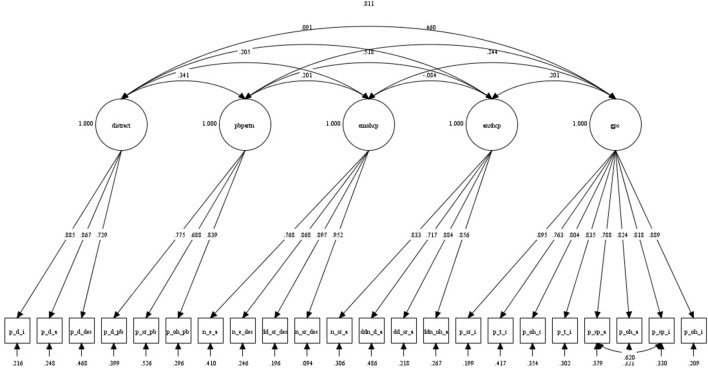
Five-factor model derived from CFA in N = 180 individuals thinking of acute back pain (Study 4). The figure shows completely standardized estimates which, if squared, correspond to percentage variance in observed measure accounted for by the latent factor. “gps” denotes General Partner Support, “anxhcp” Anxiety in Context of HCPs, “emohcp” Emotional Support from HCPs, “pbpartn” Pain Behaviors in Context of Partner, and “distract” denotes the Distraction by Partner factor. Indicator abbreviations are explained in Table 2.